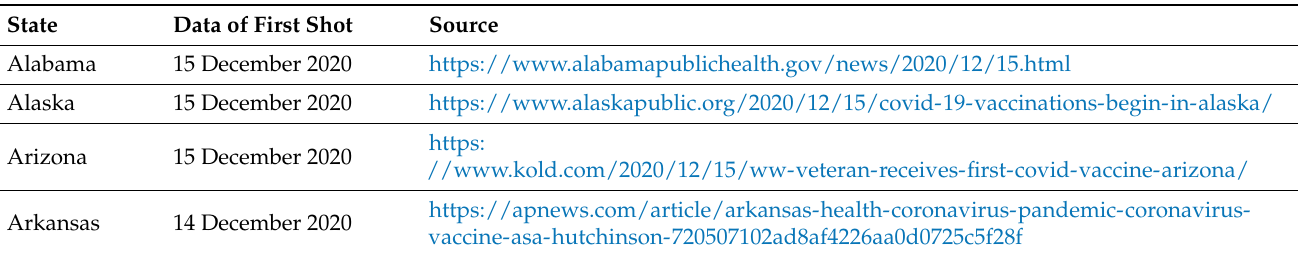
Table A1. Source news for the first dose of COVID-19 vaccine administered on every state in the US. State Data of First